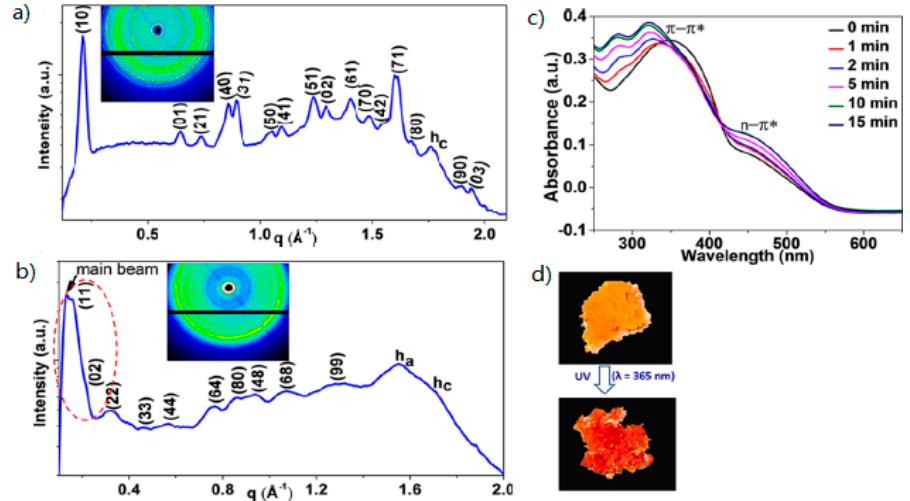
Figure 20. The XRD pattern of compound 63b in the solid-state ( a , b ) before and after the UV illumination, ( c ) the solid-state UV-vis experiment before and after UV irradiation and ( d ) the photochromism in solid-state changes the colour of solid before and after the light exposure. (Reproduced with permission from ref. [153], copyright American Chemical Society 2019, https://doi.org/10.1021/acs.jpcb.9b01456).